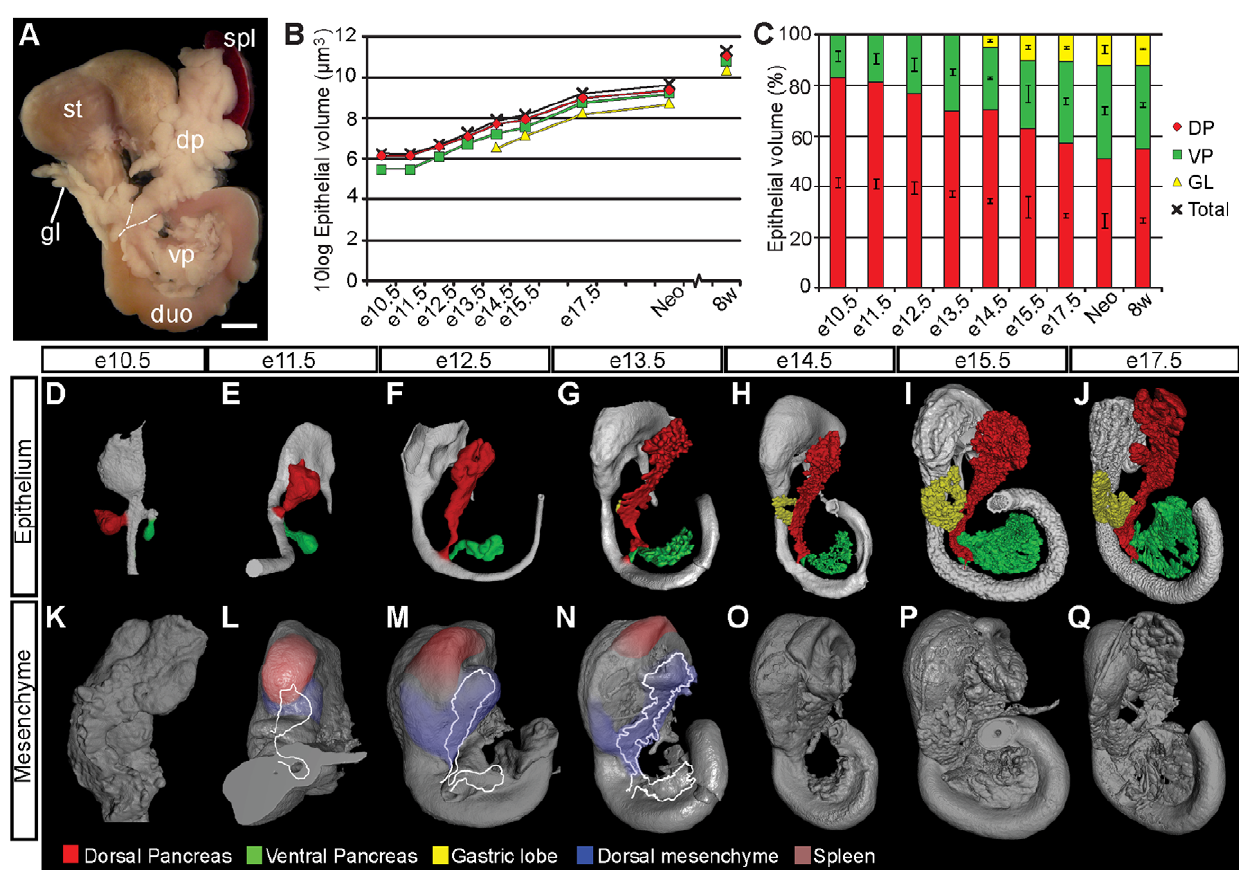
Figure 1. The gastric lobe constitutes a significant portion of the mouse pancreas and is formed by perpendicular growth from the stalk of the dorsal pancreas into a lateral mesenchymal domain positioned in close proximity to the pyloric sphincter and pyloric antrum. ( A ) Photomicrograph of a gut segment including the stomach, duodenum, spleen and pancreas from a C57Bl/6 mouse at 8 weeks. ( B ) Graph depicting the 10log values of the epithelial volume of the DP (yellow diamond), VP (green square), GL (yellow triangle) and the entire pancreas (black cross) between e10.5 and 8 weeks. ( C ) Relative lobular volumes between e10.5 and 8 weeks. From e15.5 onwards, the gastric lobe constitutes more than 10% of the pancreatic epithelium. DP: red; VP: green; GL: yellow. Data in ( B , C ) is derived from analyses of C57Bl/6 mice. Values in ( C ) are given 6 SEM. ( D through Q ) OPT generated iso-surface reconstructions of gut segments including the stomach, duodenum, spleen and pancreas between e10.5 to e17.5 based on the signal from E-cadherin antibodies (epithelium, D to J ) and the signal from tissue autofluorescence (mesenchyme, K to Q ). The condensation and migration of primordial spleen cells in an anterior direction results in the formation of a lateral mesenchymal domain which provides the template for growth from the stalk of the dorsal pancreatic epithelium. ( D to J ) The dorsal, ventral and gastric epithelium have been pseudocolored red, green and yellow respectively. ( L to N ) The dorsal mesenchyme and the spleen primordium have been pseudocolored blue and pink respectively. The specimens in ( D – Q ) are not depicted to scale. Scale bar in A is 3